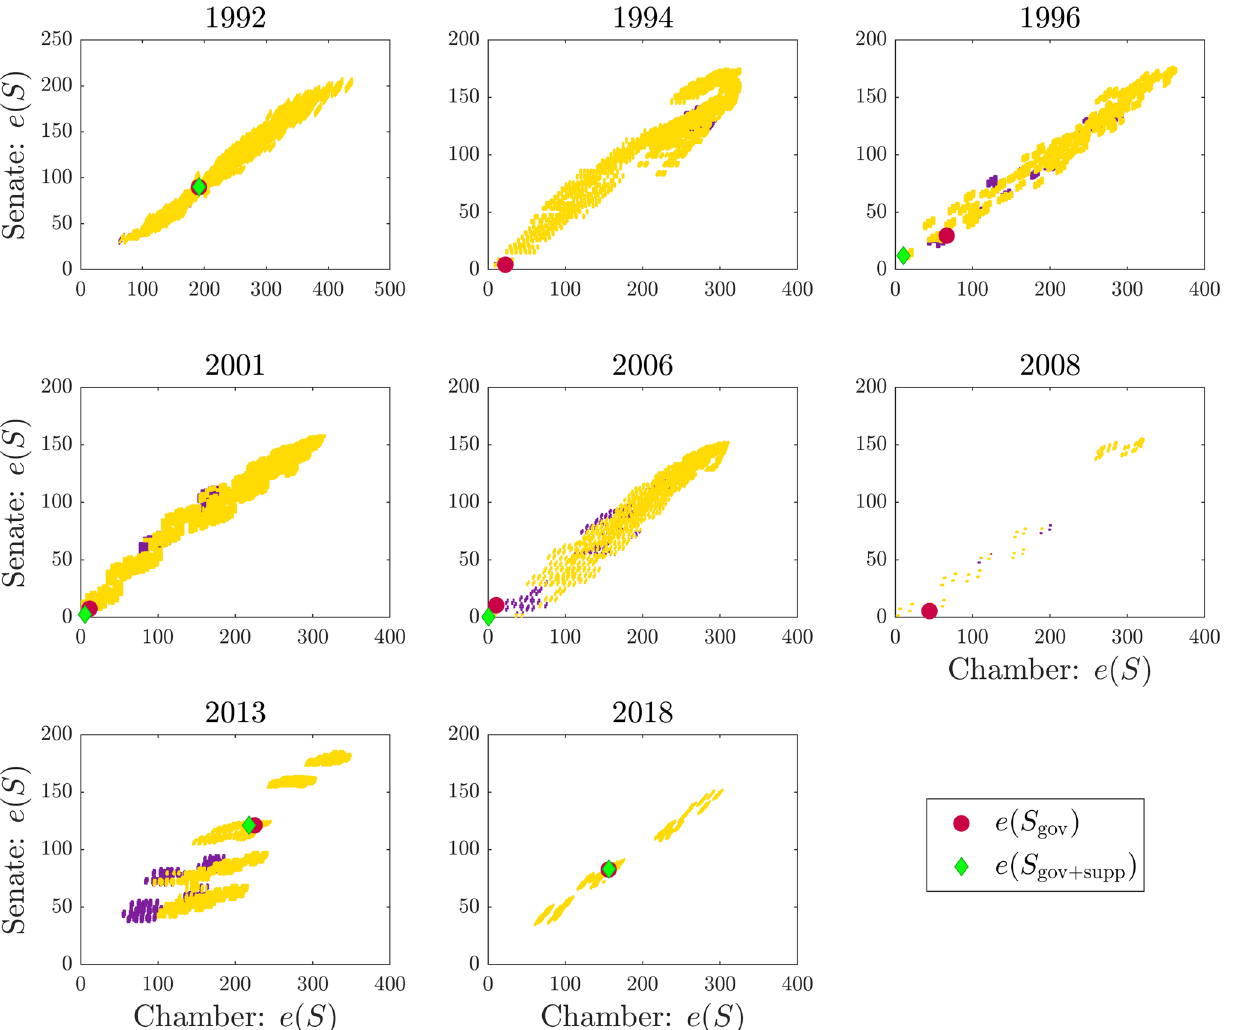
Figure 6. Comparison of the energy landscapes in the Chamber of Deputies and Senate of the Republic in Italy for scenario III . The red dot indicates the value of the energy functional corresponding to the government configuration S gov , while the green diamond indicates the value of the energy functional corresponding to the party configuration S gov + supp , which includes also the parties providing external support to the government in the parliament (see “Methods”). The values of the energy functional corresponding to majority configurations (i.e., party coalitions holding majority of seats in both chambers of the parliament) are highlighted with a yellow color, while a purple color indicates party coalitions which have the majority of seats in only one chamber (see “Supplementary Information” for